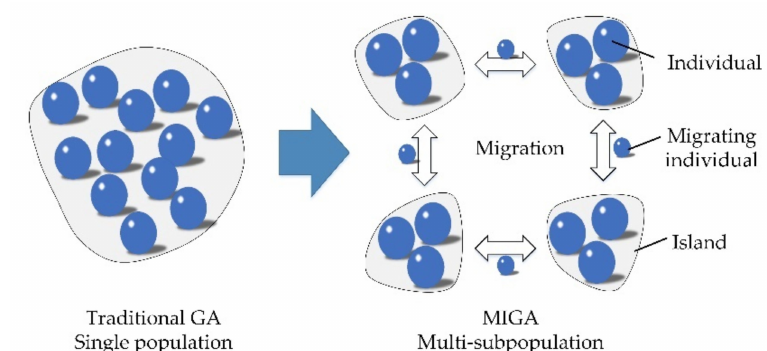
Figure 2. Migration operation of dynamic multi-island genetic algorithm (DMIGA).